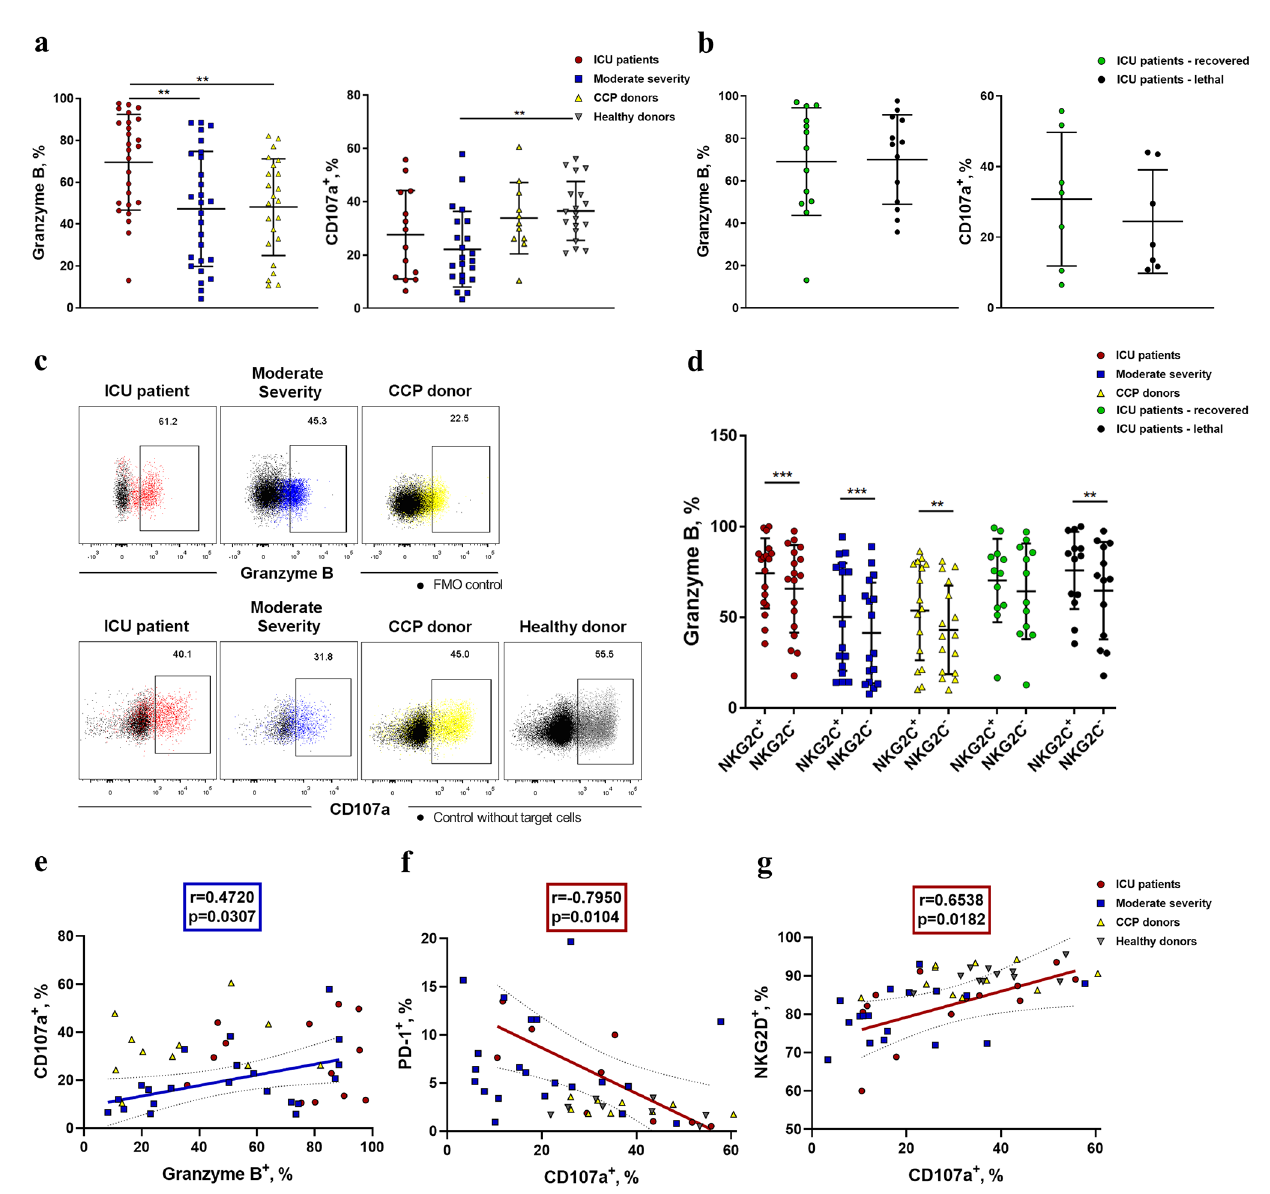
Figure 7. Degranulation activity and granzyme B expression in NK cells from COVID-19 patients, convalescent patients, and healthy donors. ( a ) The proportion of CD107a + and granzyme B + NK cells in the following comparison groups: ICU patients (n = 14 and n = 26, respectively), moderate-severity patients (n = 22 and n = 27, respectively), CCP donors (n = 11 and n = 23, respectively), and healthy donors (n = 18 only for CD107a). ( b ) Comparative analysis of CD107a + and granzyme B + NK cell levels in the recovered and non-recovered patient groups from the ICU. ( c ) Representative dot plots of CD107a and granzyme B expression in NK cells in all studied groups with the respective controls without target cells (K562) or FMO (fluorescence minus one) controls (black), the meaning of other colors is highlighted in the upper part of dot plots. ( d ) Comparative analysis of granzyme B + cell level among NKG2C +/ − NK cells measured in the following comparison groups: ICU patients (n = 26), moderate-severity patients (n = 27), CCP donors (n = 23), ICU patients—recovered (n = 12), and ICU patients—non-survivors (n = 13). ( e ) Spearman correlation between the proportions of CD107 + and granzyme B + NK cells in the studied groups. ( f ) Pearson correlation between the proportions of CD107 + and PD-1 + NK cells in the studied groups. ( g ) Spearman correlation between the proportions of CD107 + and NKG2D + NK cells in the studied groups. ( a , b , d ) Data are presented as individual values with mean ( ± SD). ** p < 0.01, *** p <